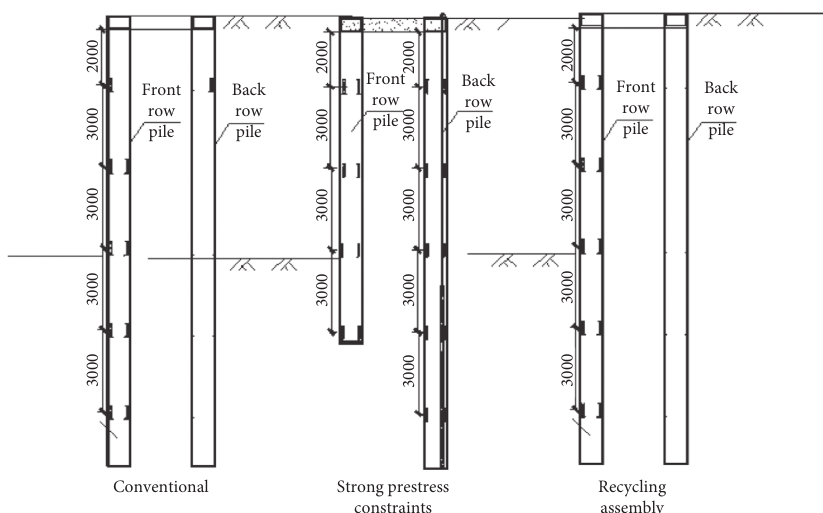
Figure 11: Pile strain measuring point layout elevation.